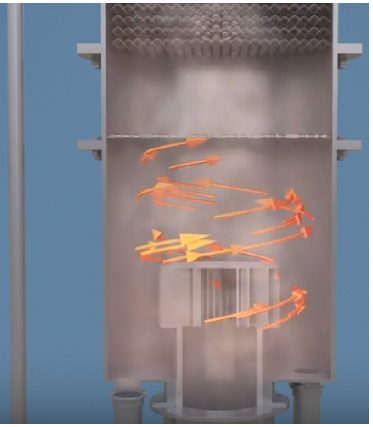
Figure 7. Schematic diagram of a SO x scrubber system with swirling gas flow